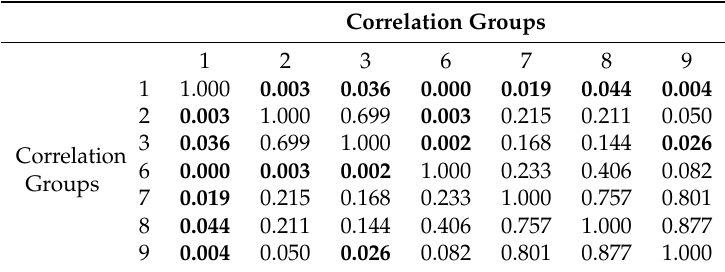
Table 8. p -values between the mean results of variable V 7 “melanin” obtained from the spectra of the corresponding correlation